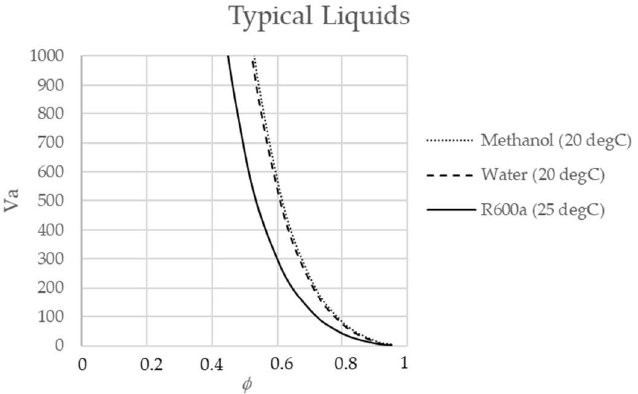
Figure 2. Vadasz number illustrated for typical liquids, used in engineering applications. Here, φ is the porosity.